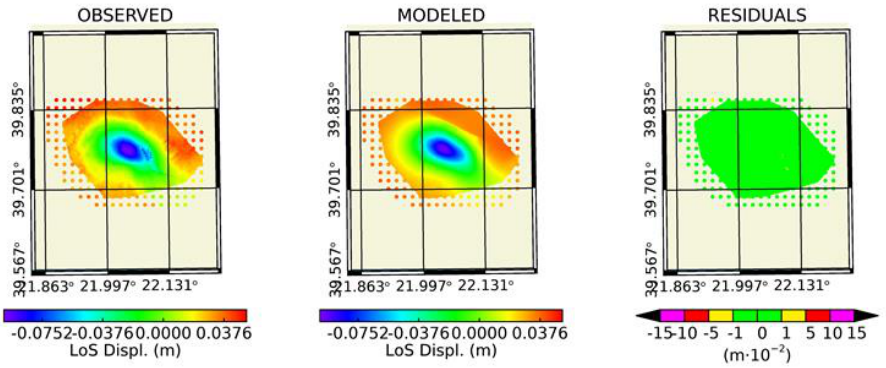
Figure 13. Comparison of LoS displacements from observed and modeled data for the second earthquake (4 March 2021) using the ascending mode.